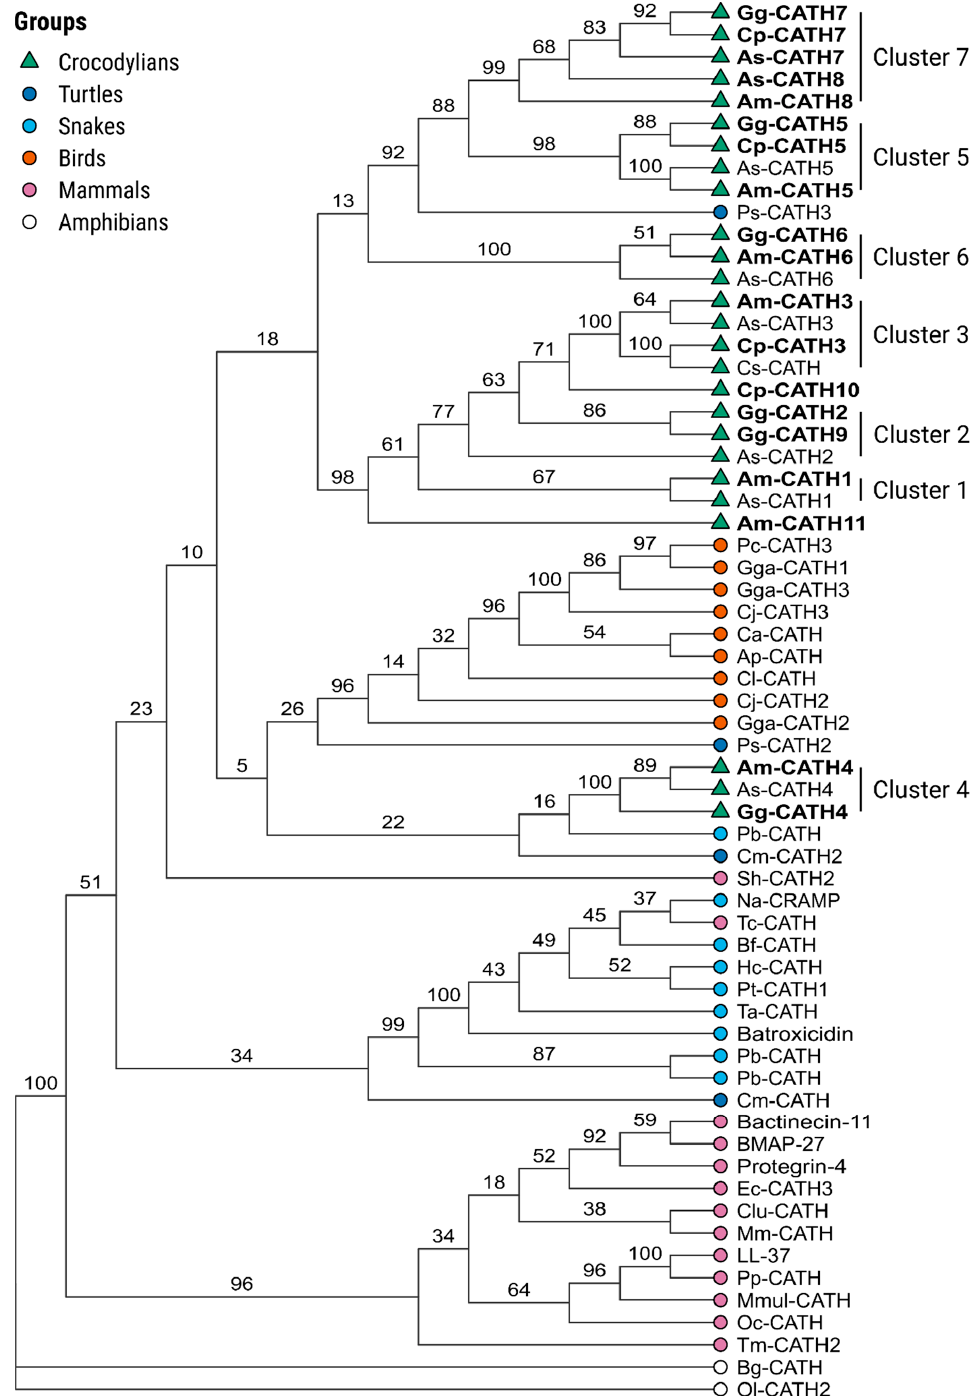
Figure 1. Phylogenetic analysis of crocCATH sequences. The tree was generated using the maximum likelihood criterion implemented in the RaxML program. The analysis included the full-length crocodylian amino acid sequences, as well as sequences from other reptilian, avian and mammalian species. Newly identified crocCATH sequences are displayed in bold. The amphibian cathelicidins Bg-CATH and Ol-CATH2 were used as outgroups to root the tree. Branch numbers indicate statis- tical support as percent after 1000 bootstrap replicates. The seven identified crocodylian clusters are indicated in the figure, which were named according to the previously described A. sinensis cathelicidins [18]. The alligator cathelicidin AM-36 [19] was renamed here as Am-CATH4.